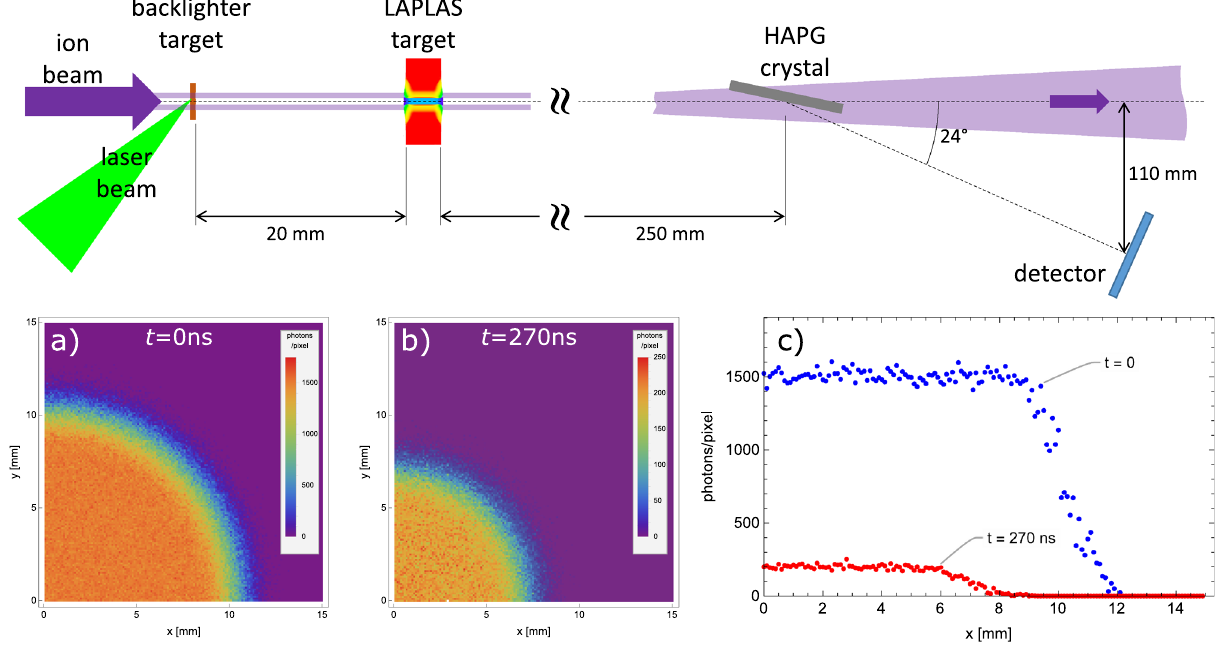
Figure 13. (top) Schematic of the proposed set up for on-axis radiographic imaging using a laser-driven X-ray source, and (bottom) simulated radiographic images of ( a ) the initial target, ( b ) after compression at a time of 270 ns, and ( c ) central lineouts at both probe